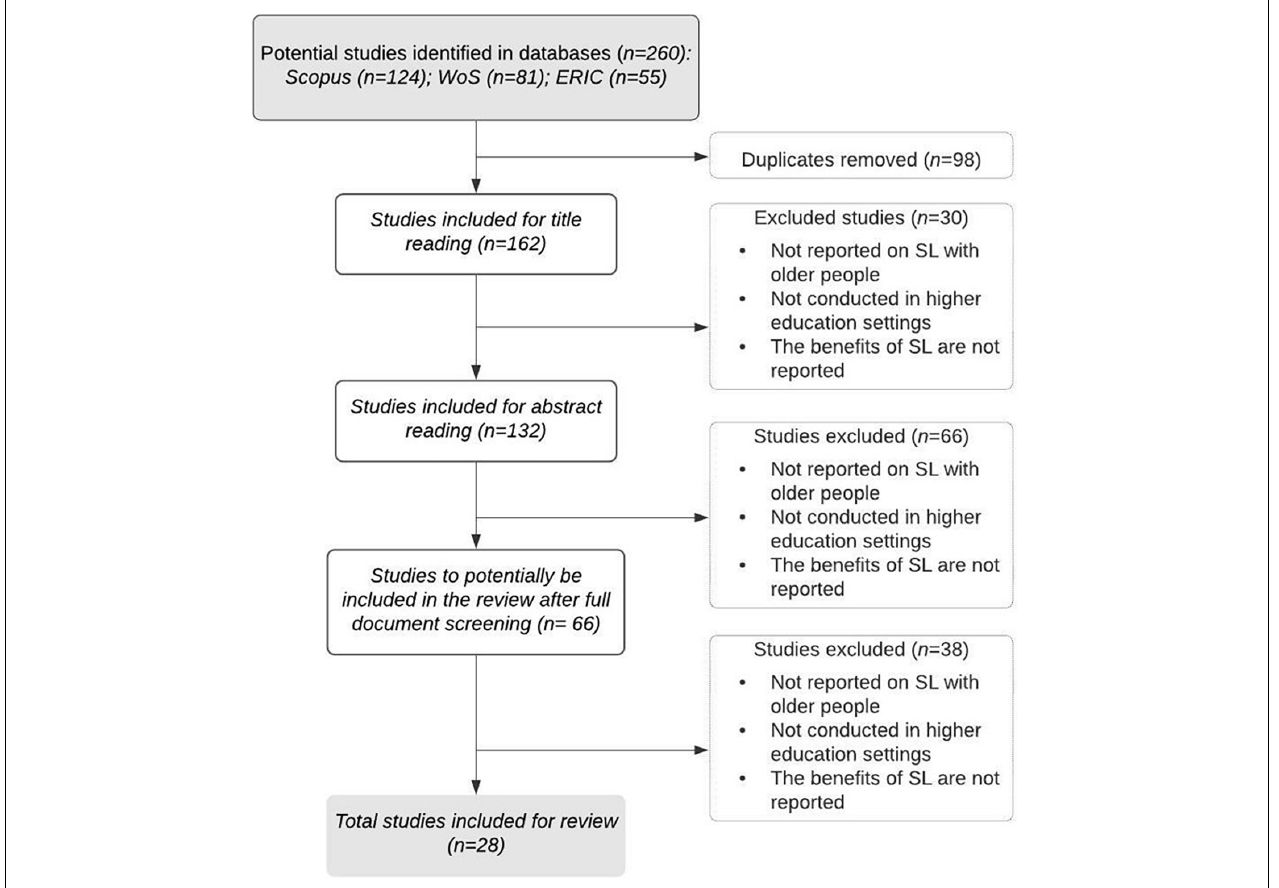
FIGURE 1 | Flow chart of the study selection